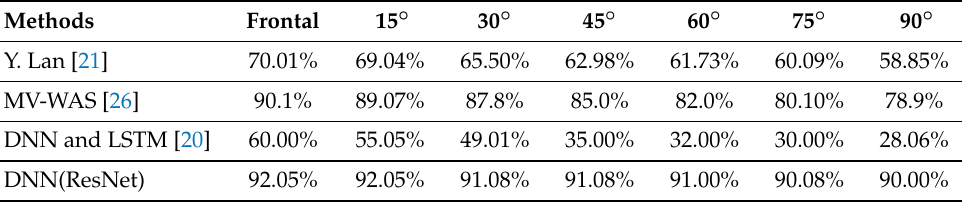
Table 5. Performance measure over multiple poses by using different methods.